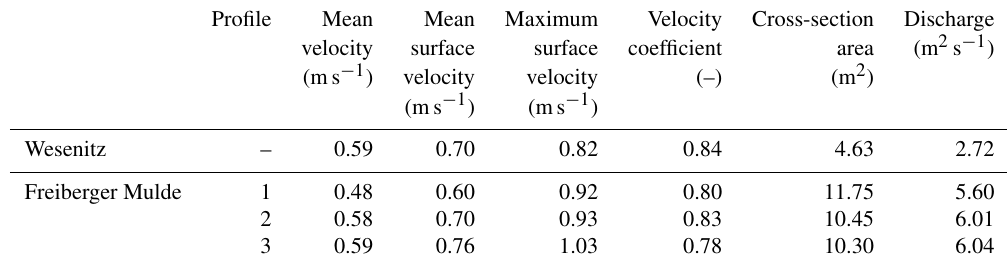
Table 1. River velocities measured with